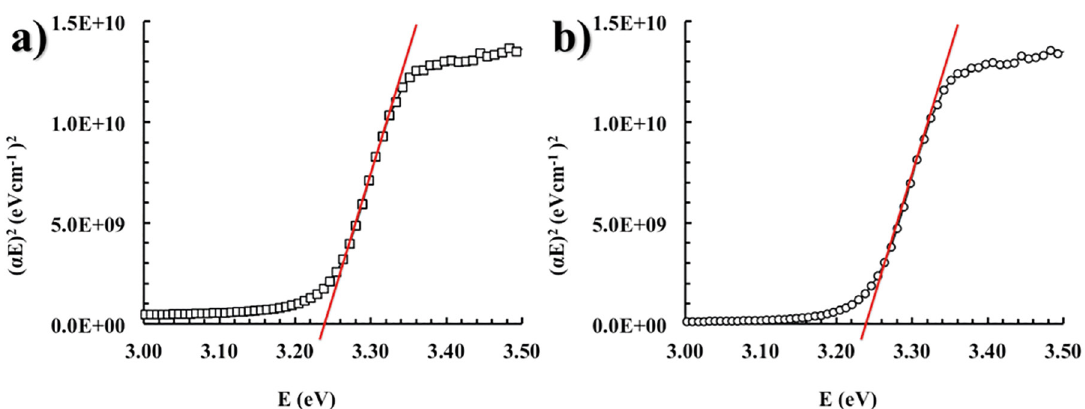
Figure 4. Tauc’s plots obtained through the applications of standard equations in a) M1 and b) M2. All cases indicate a BG of 3.24 ± 0.01 eV.